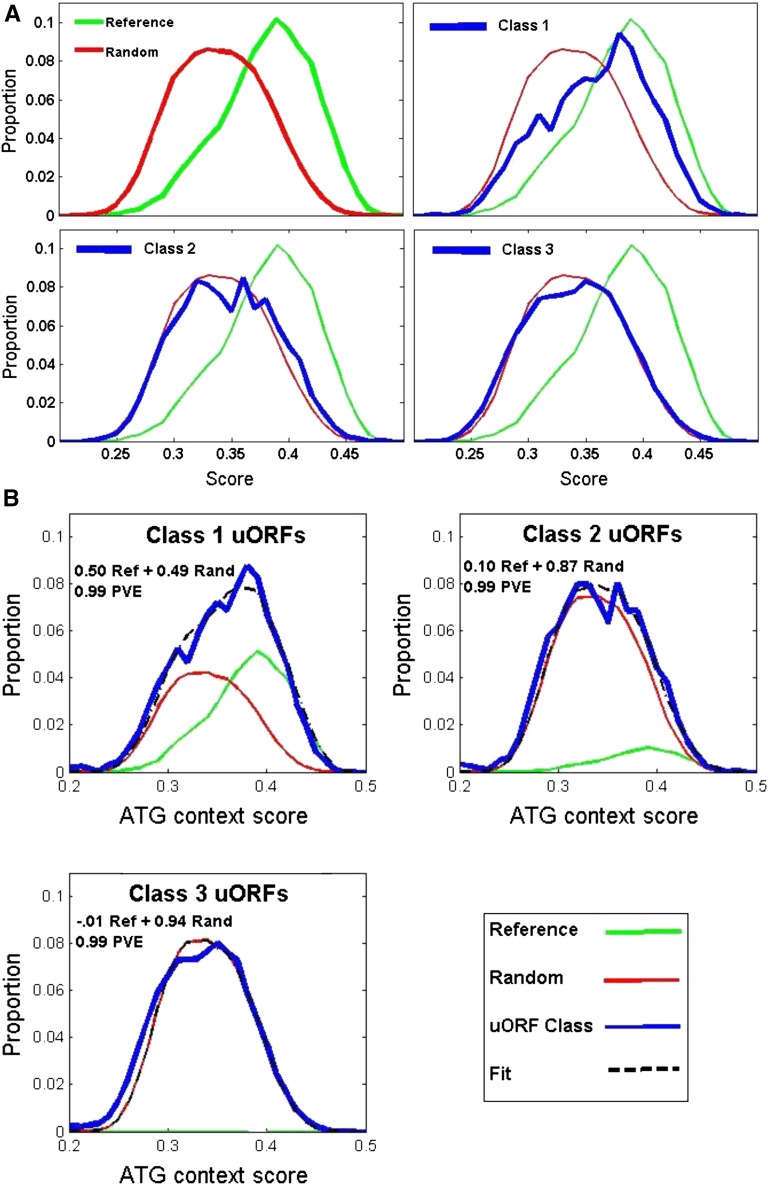
Class 1 uORFs, but not Class 2 or Class 3 uORFs, show significant agreement to the Kozak consensus. (A) Reference, random, and uORF agreement with the consensus. A ‘Kozak score’ was defined as the sum of bits corresponding to the observed nucleotides at each position surrounding the ATG (Figure 3). Top left: comparison of scores of reference initiator ATGs (green) to scores of 100,000 random sequences composed with the nucleotide frequency of 5UT (red). Remaining panels: uORFs (blue) compared to reference and random distributions. (B) Projection of uORFs onto space spanned by reference initiators and random sequence. Define Matrix A = [distribution of reference;distribution of random]; vector C = distribution of uORF; then [c1 c2] = (ATA)-1 ATC gives the least-squares best-fit solution for c1 × reference distribution + c2 * random distribution ≈ C (Strang 2009). The best fit is the dotted black line; weights and proportion of variance explained (PVE) are indicated.